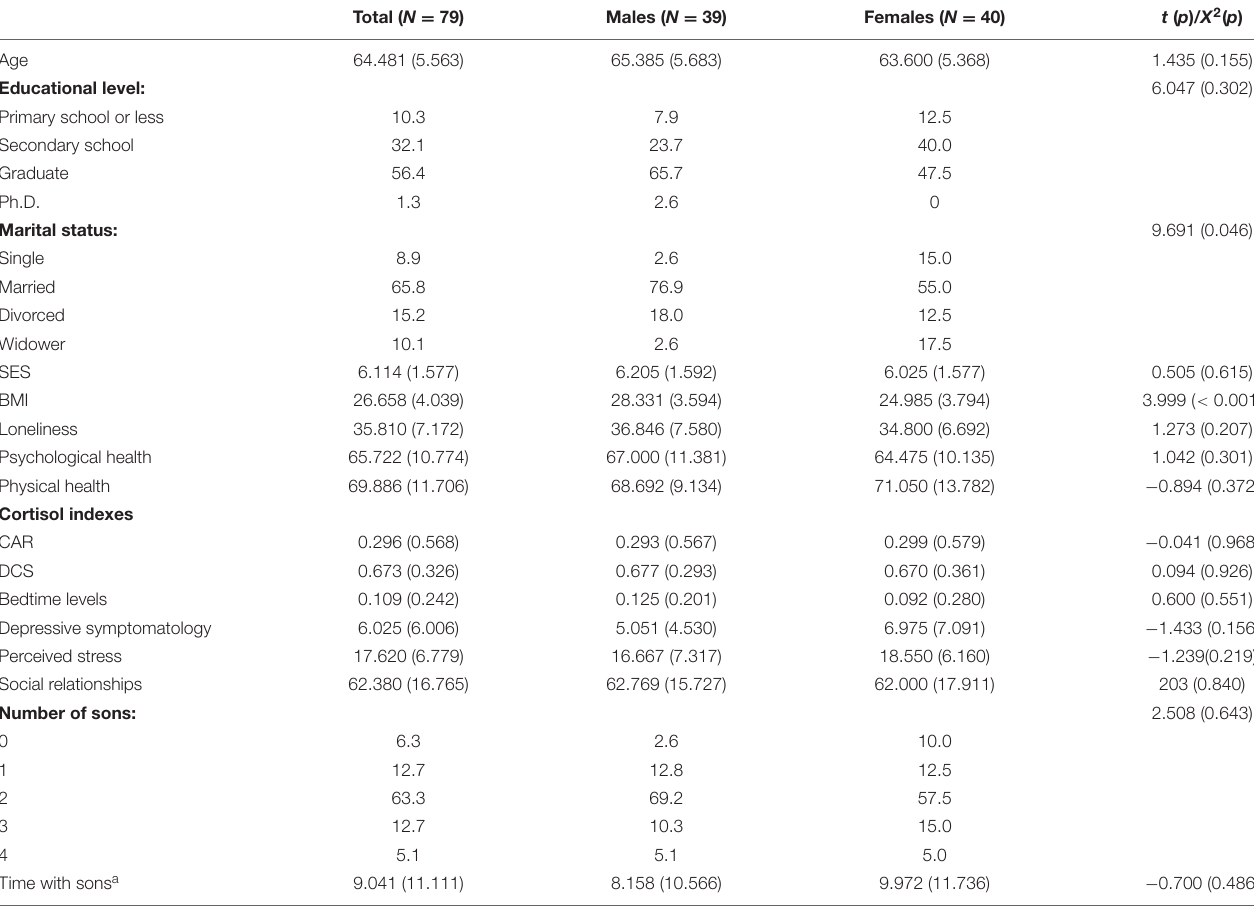
TABLE 1 | Characteristics of the total sample and for males and females.